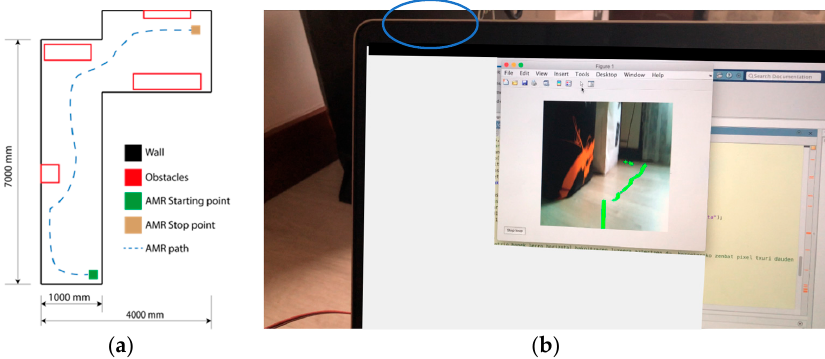
Figure 15. The obstacle avoidance in 94.6 s: ( a ) The representation in the sketch and ( b ) the path calculation in the real scenario.